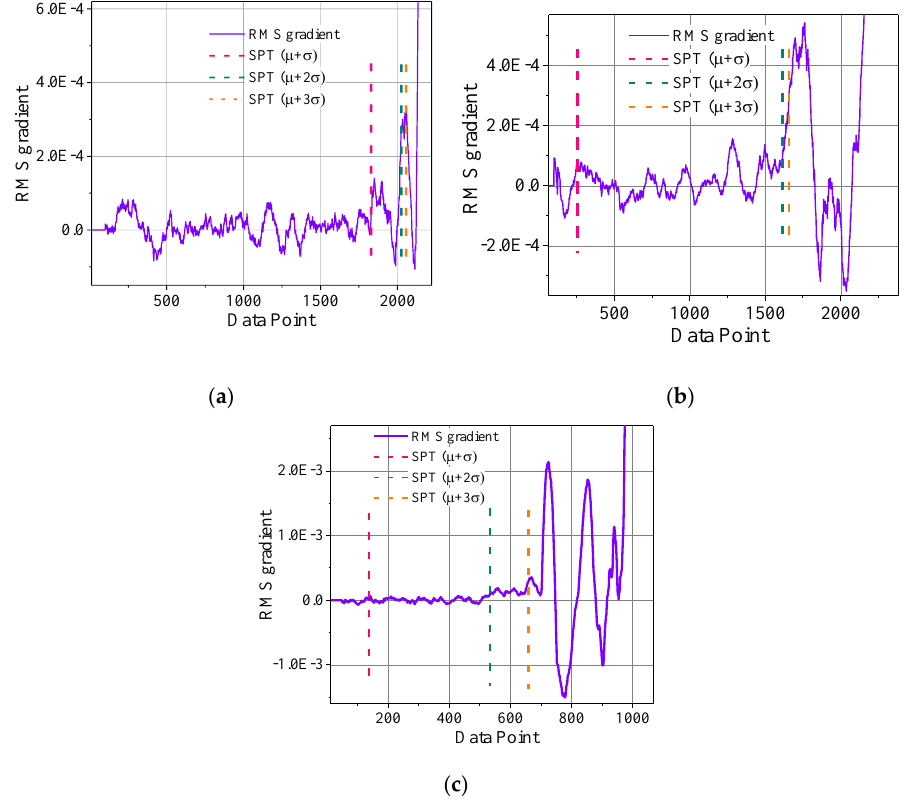
Figure 8. SPT under different thresholds: ( a ) Bearing 1, ( b ) Bearing 2, and ( c ) Bearing 3.